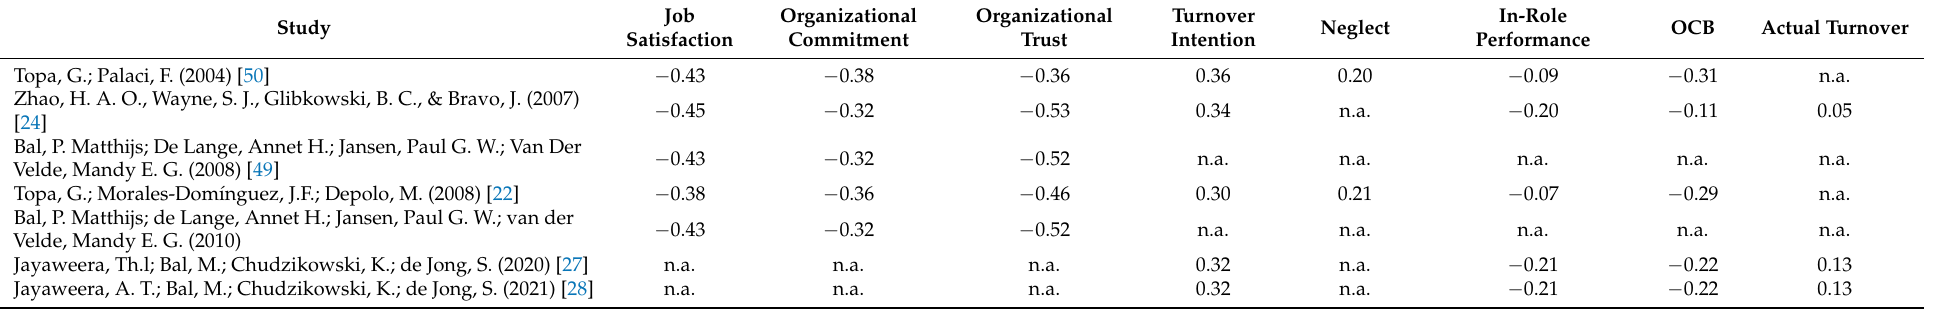
Table 6. Mean effect size for the psychological contract breach–Outcome relationship reported by the included